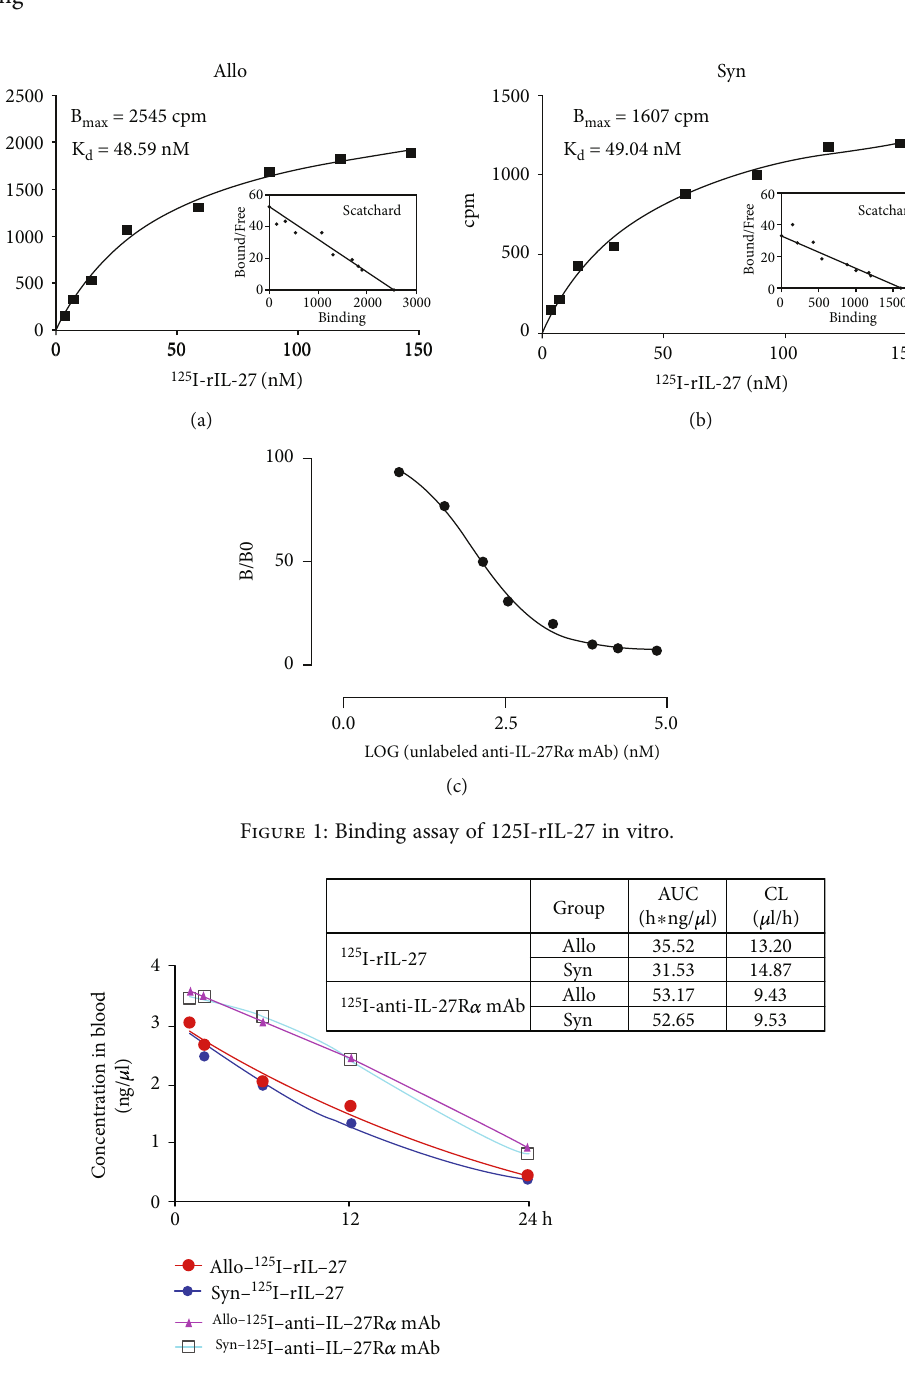
Figure 2: Blood clearance